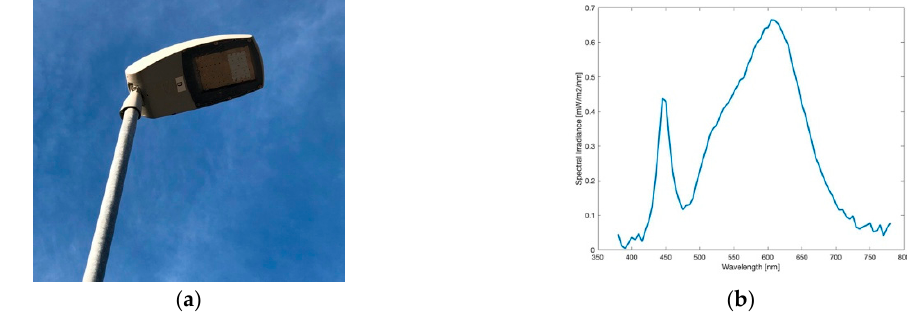
Figure 3. ( a ) Image of the light emitting diode (LED) lamp during daytime; ( b ) Spectrum of lamp